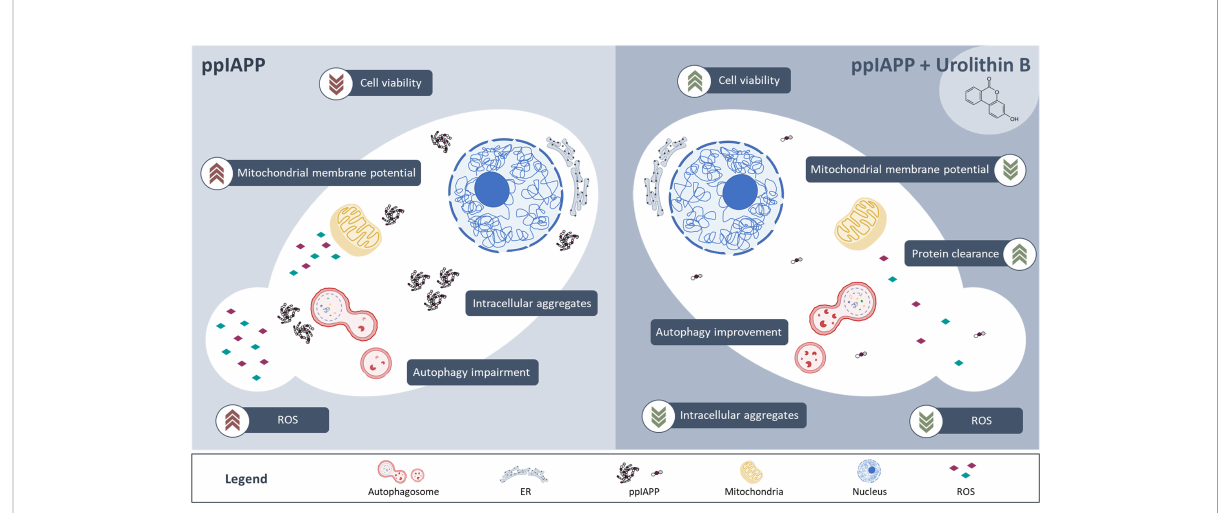
FIGURE 7 IAPP expression in yeast leads to the deposition of intracellular aggregates, which in turn interfere with multiple cellular functions such as autophagy, mitochondrial membrane potential homeostasis and redox homeostasis culminating with reduced cell viability and growth (left panel). Treatment of cells with urolithin B protects against IAPP proteotoxicity, preventing the accumulation of toxic intracellular aggregates, improving cellular functions and cell viability (right